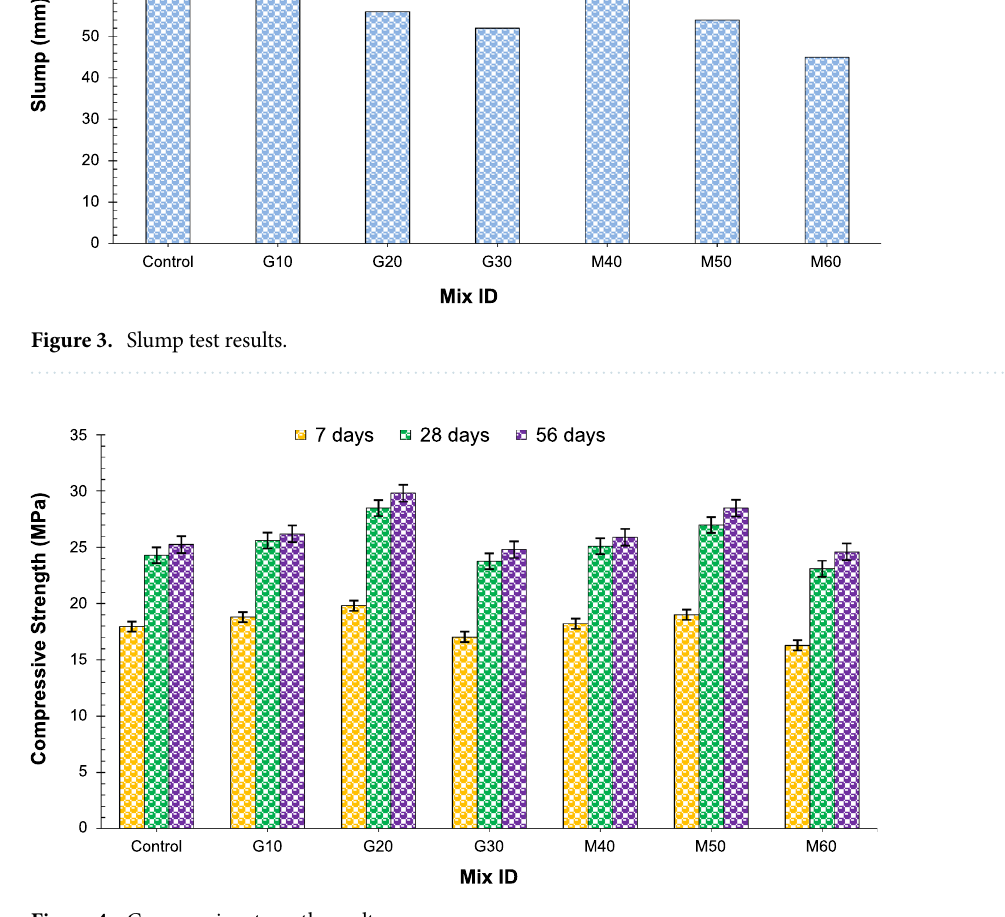
Figure 4. Compressive strength